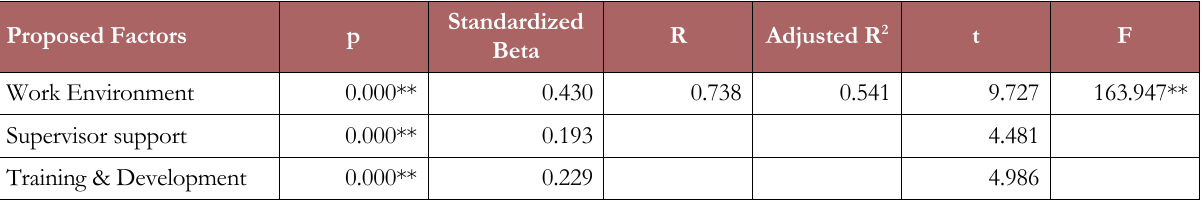
Table 2. Multilinear regression analysis of organization commitment on proposed factors [n =